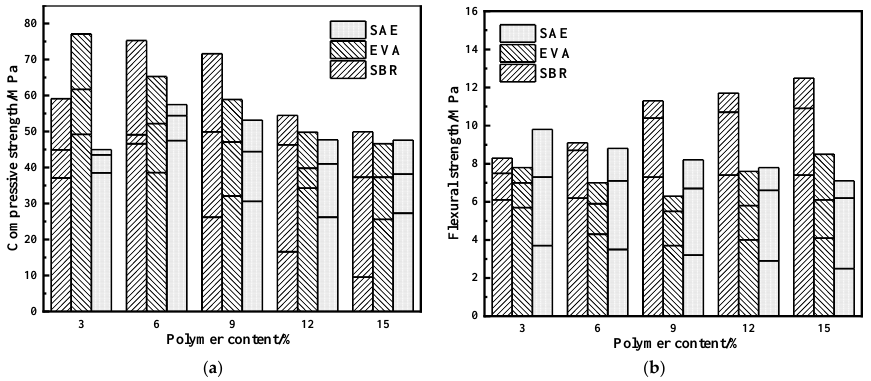
Figure 2. Effect of polymer latex content and type on compressive/flexural strength of mortar samples: ( a ) compressive strength; ( b ) flexural strength.